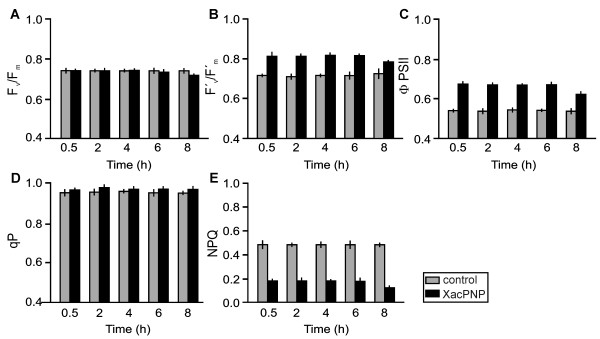
Chlorophyll fluorescence parameters in citrus leaves treated with XacPNP. (A) Potential quantum efficiency of PSII (Fv/Fm); (B) effective quantum efficiency of PSII (F'v/F'm); (C) PSII operating efficiency (ϕPSII); (D) photochemical fluorescence quenching (qP) and (E) nonphotochemical fluorescence quenching (NPQ) of control and XacPNP-infiltrated citrus leaves at the times stated. The results are the mean of six replicates and error bars represent the standard deviations.